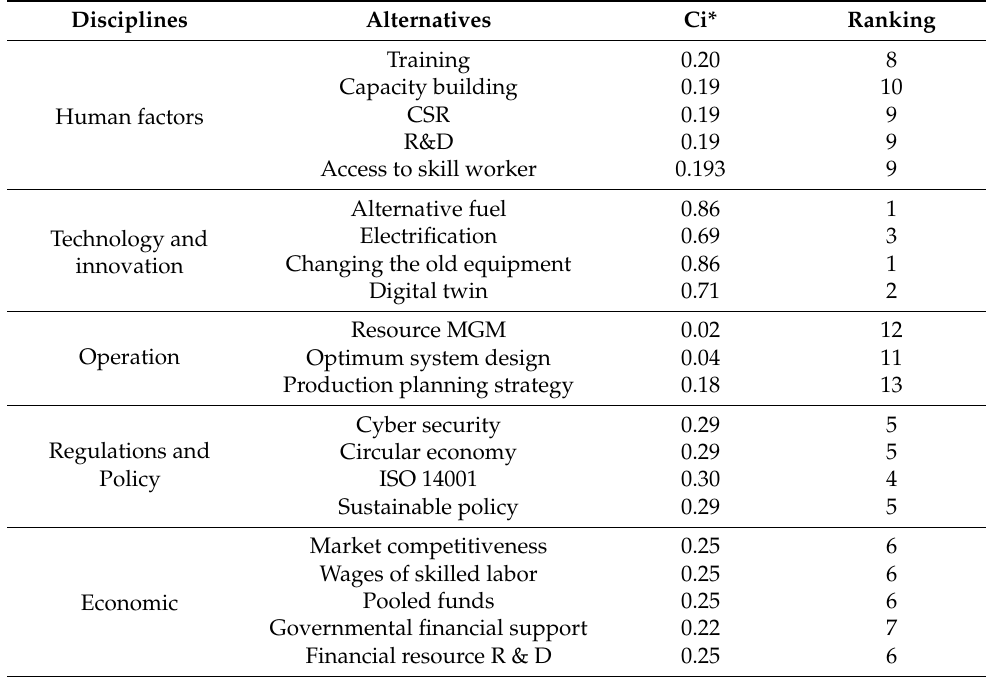
Table 9. Highest ranked